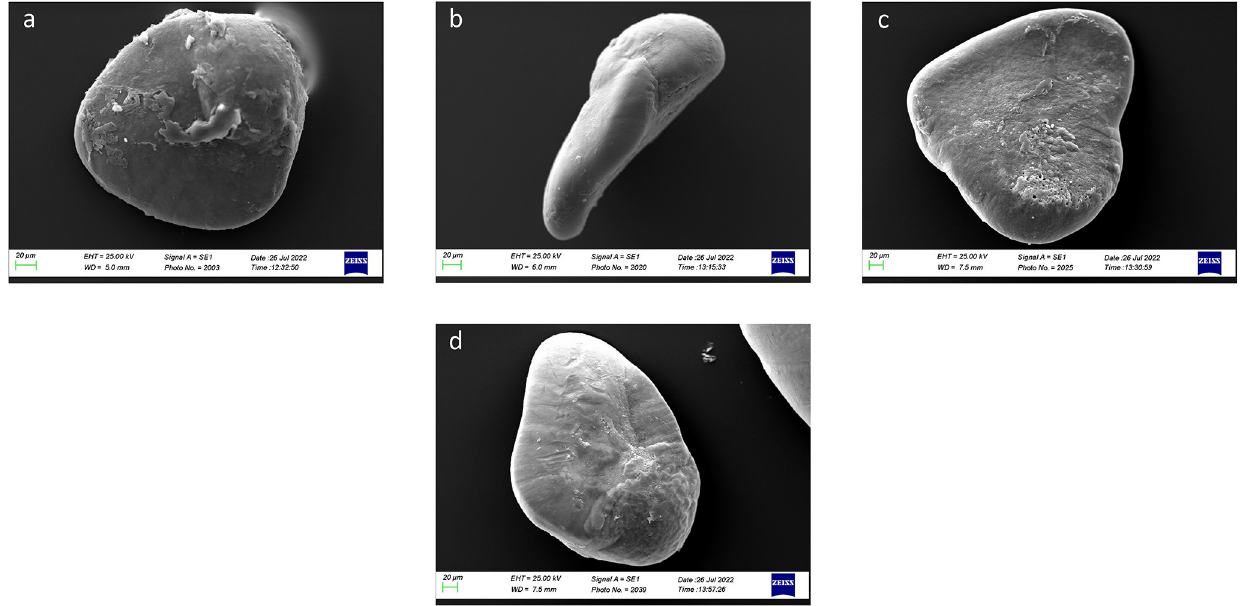
Fig 17. SEM images of ventral (a, d), lateral (b) and dorsal (c) surfaces of A . hemigymnus’ lapilli separated for size classes: Class I (a), Class II (b), Class III (c) and Class IV (d).